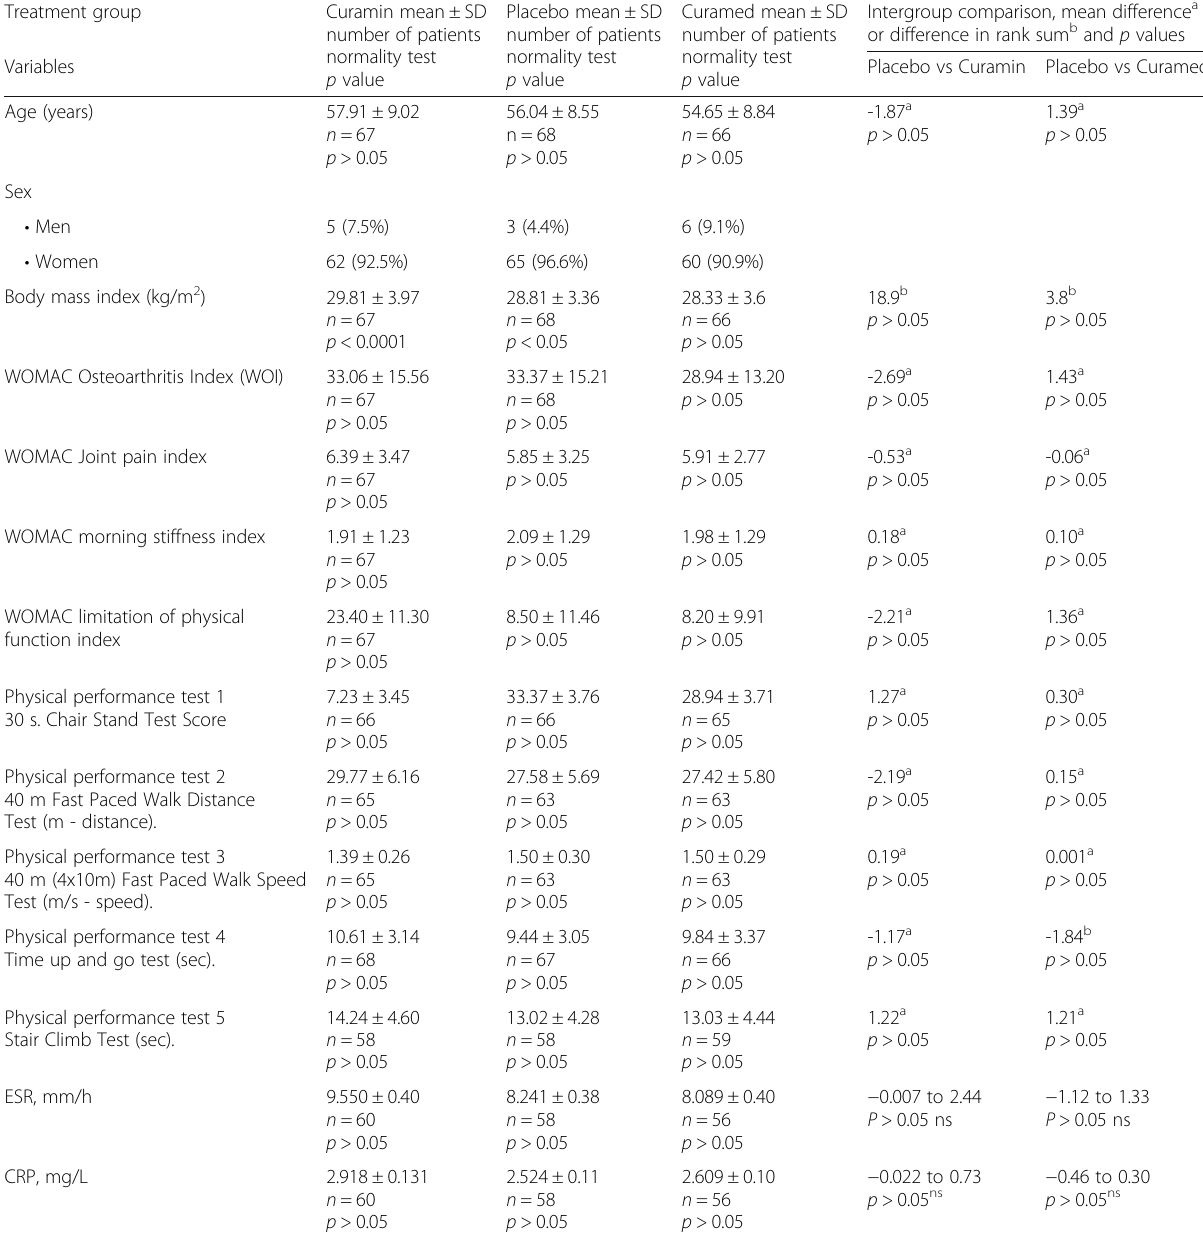
Table 2 Baseline characteristics of study participants allocated to interventions, n = 201 Treatment